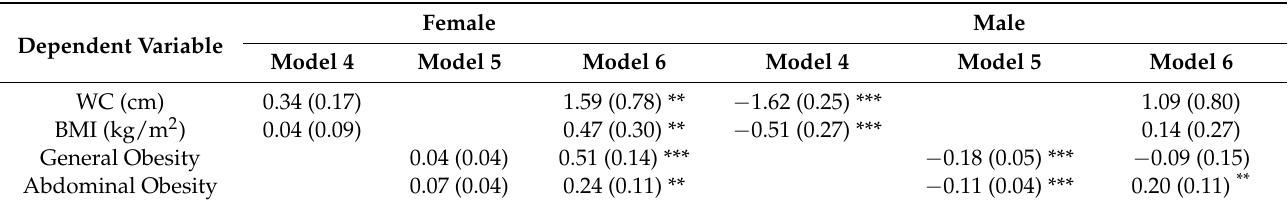
Table 4. Effects of NRCMS on the probability of having general obesity and abdominal